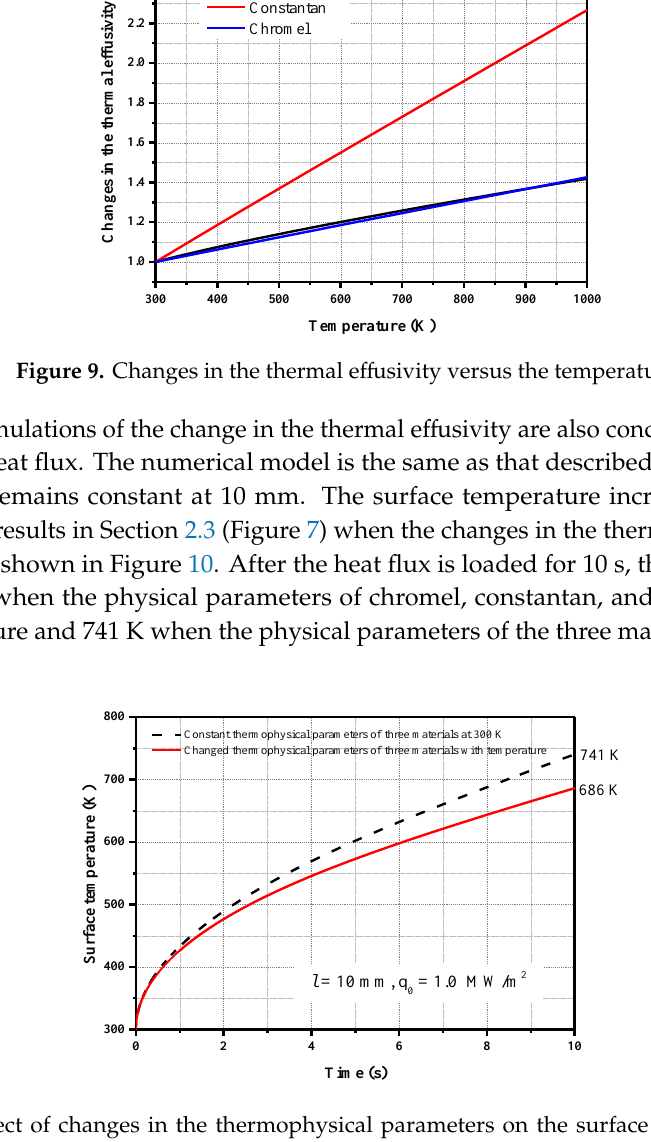
Figure 10. Effect of changes in the thermophysical parameters on the surface temperature of the junction ( q 0 = 1.0 MW/m 2 ).